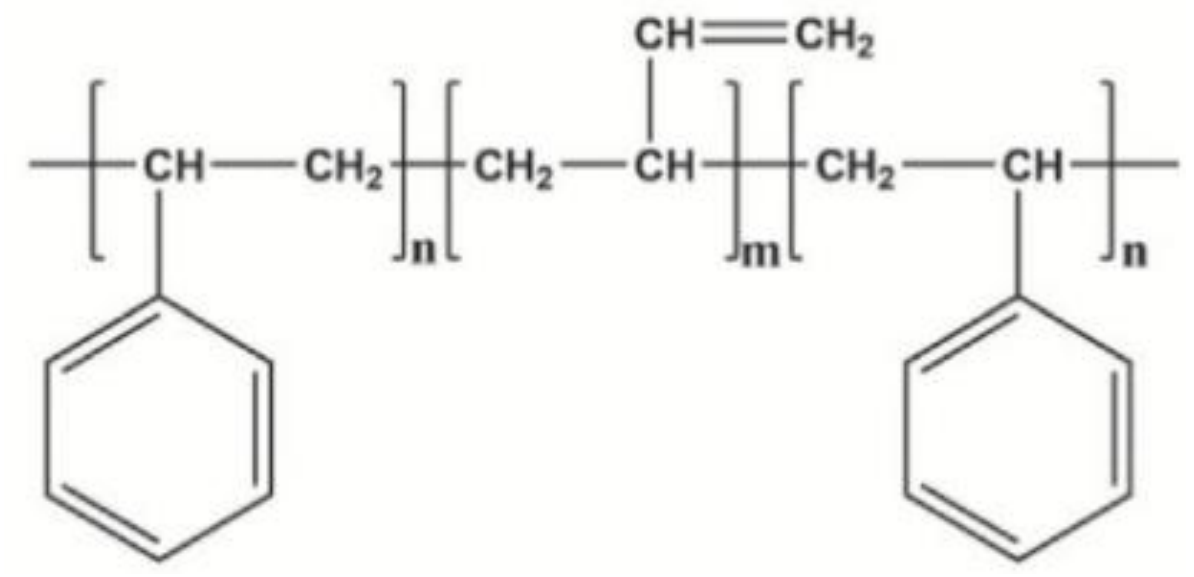
Figure 4. Structural formula SBS-R (radial triblock). Reprinted from ref. [37].